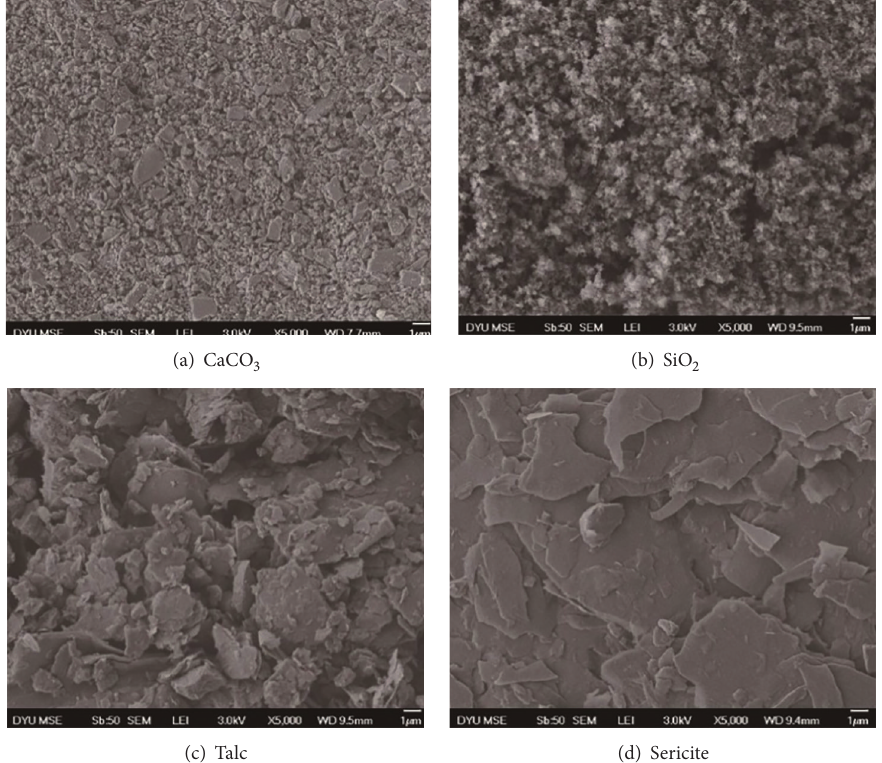
Figure 1: SEM images of the four pigments ( ×